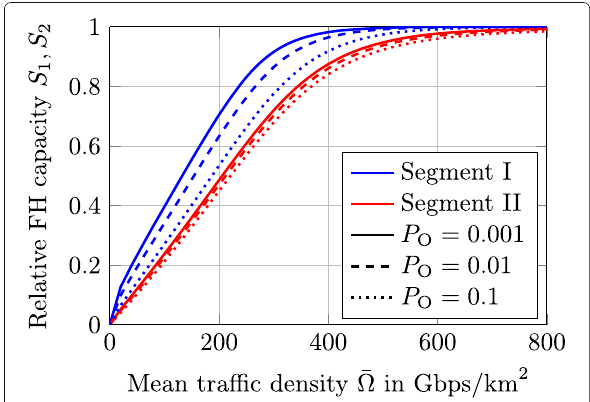
Fig. 10 Impact of outage probability. Relative FH capacity for different outage probabilities, σ (cid:8) /(cid:8) = 0.5, d corr = 50 m